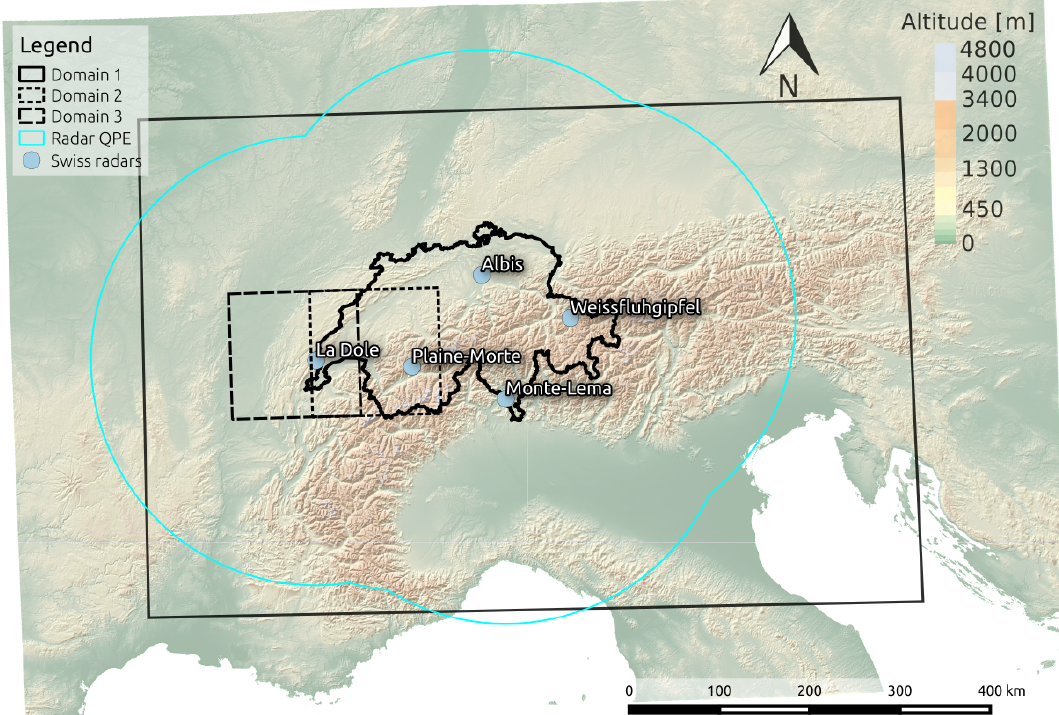
Figure 2. Situation map showing the theoretical maximum extent of available QPE (light blue), the location of the Swiss operational radars (blue dots), the region used for the climatological study of COSMO precipitation intensities (domain 1), and the subregions centered over the precipitation events used in the QPE analysis (domains 2 and